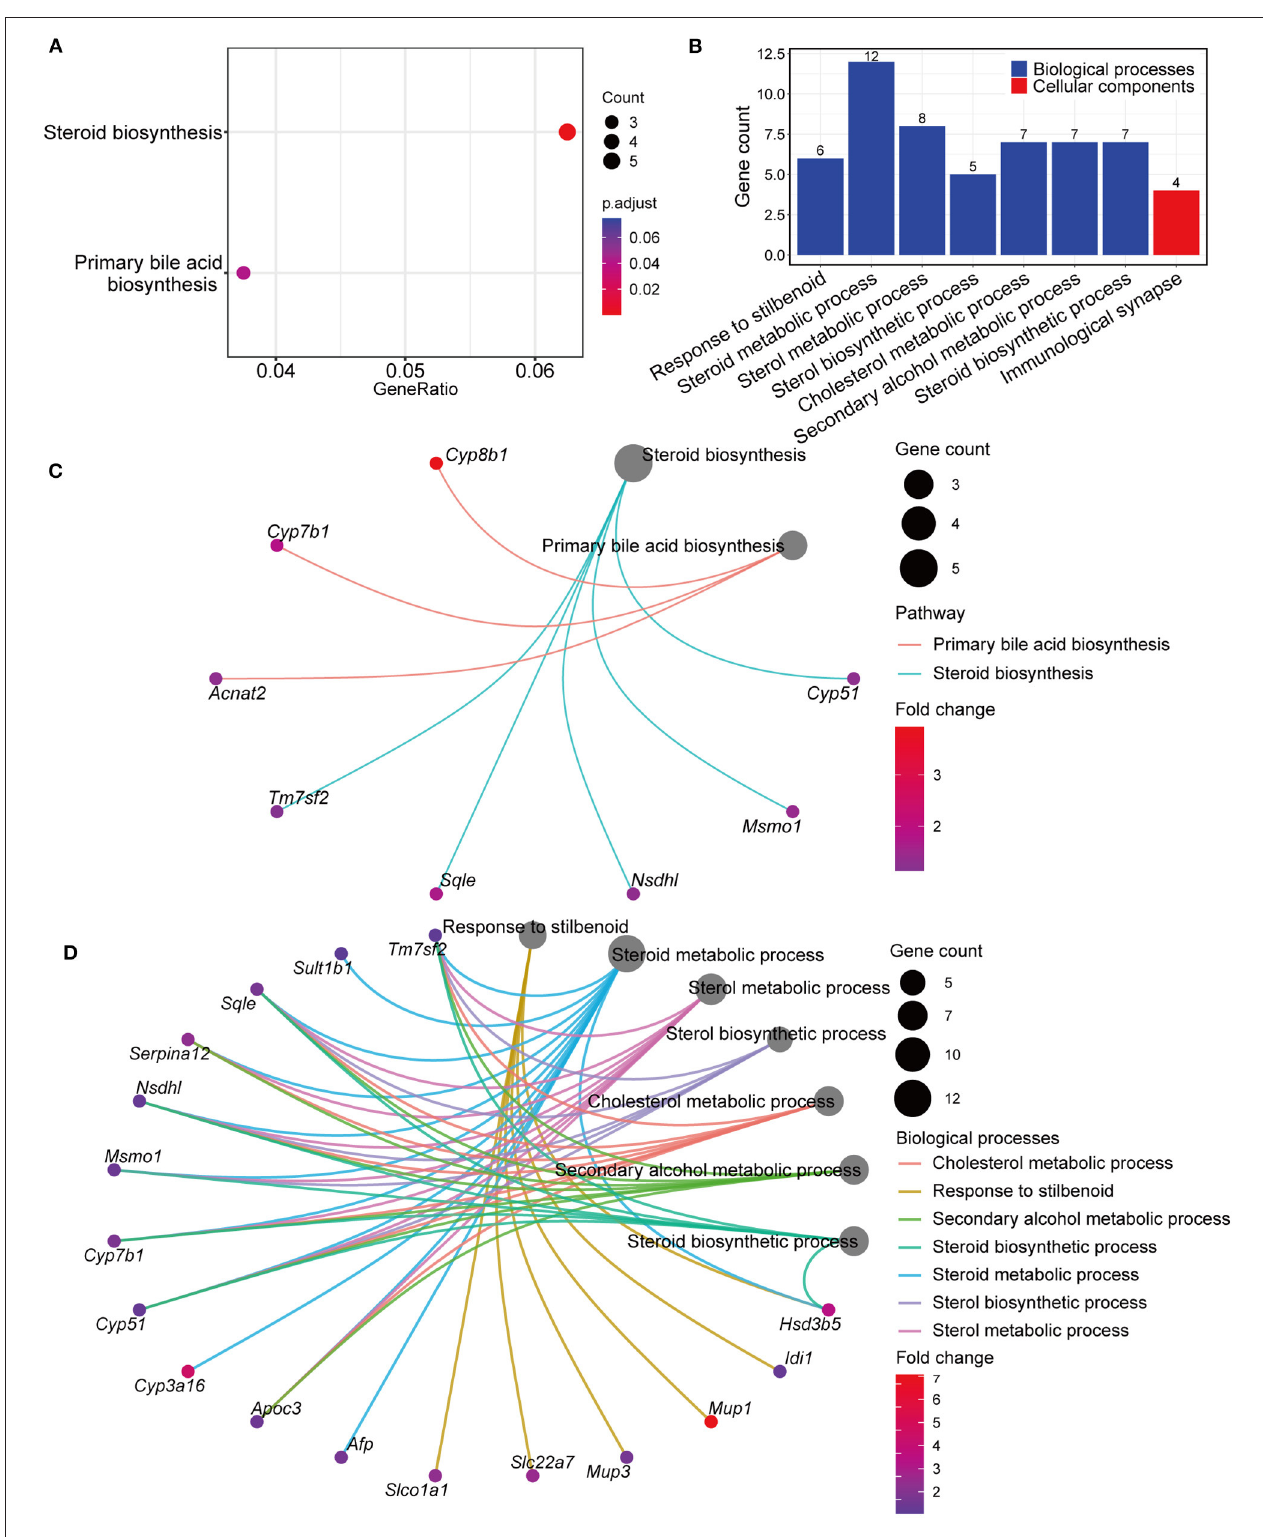
FIGURE 5 | Kyoto Encyclopedia of Genes and Genomes (KEGG) and Gene Ontology (GO) pathway enrichment analyses of genes differentially expressed in the LD and GPs groups. (A) KEGG analyses (adjusted p < 0.05). (B) Significantly enriched biological processes and cellular components (adjusted p < 0.05). (C) Gene-Concept Network analysis, depicting the linkages of genes and significantly enriched KEGG pathways. (D) Gene-Concept Network analysis of genes and significantly enriched biological processes.